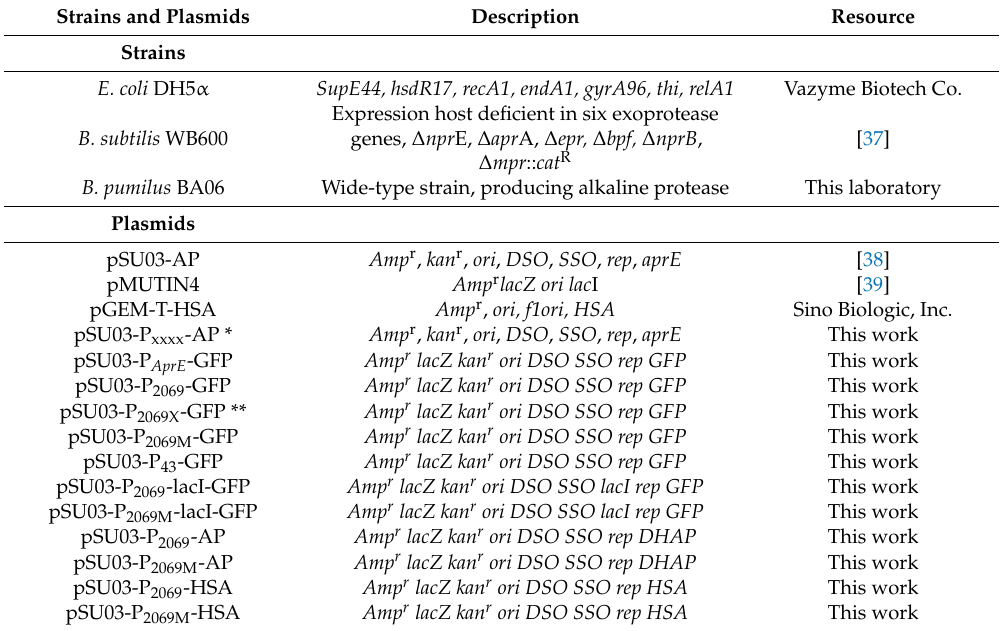
Table 1. Bacterial strains and plasmids used in this